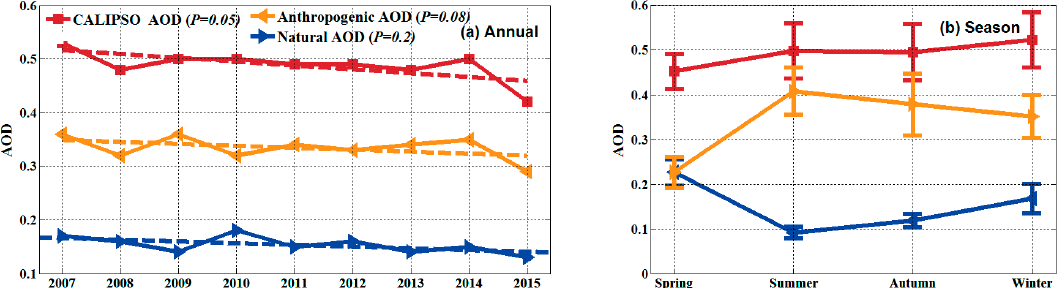
Figure 9. Annual and seasonal distributions of AOD (anthropogenic and natural), anthropogenic AOD, and natural AOD observed by CALIPSO over central China from March 2007 to February 2016. The dashed lines in Figure 9a are the linear trend fitting lines of the annual means for each aerosol parameter. p indicates the value of significance level of each aerosol parameter.